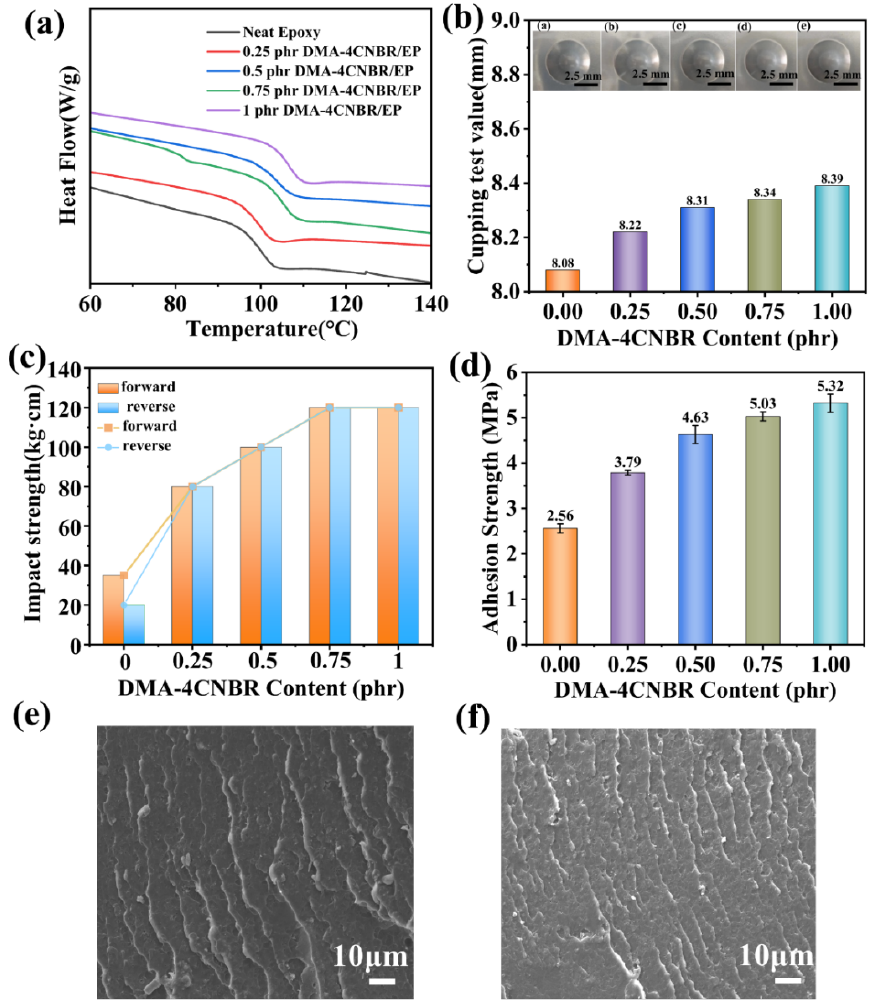
Figure 4. ( a ) DSC curves of the neat epoxy and the DMA-CNBR-modified composite epoxy coating after second heating; ( b ) cupping results of the epoxy-powder coatings; ( c ) impact strength of the epoxy resin coatings loaded with different contents of DMA-4CNBR; ( d ) adhesion test results of the nanocomposite coating with different addition amounts of DMA-4CNBR; ( e , f ) SEM photographs of fracture surface of neat epoxy coating and 1phr DMA-4CNBR-modified epoxy coating.